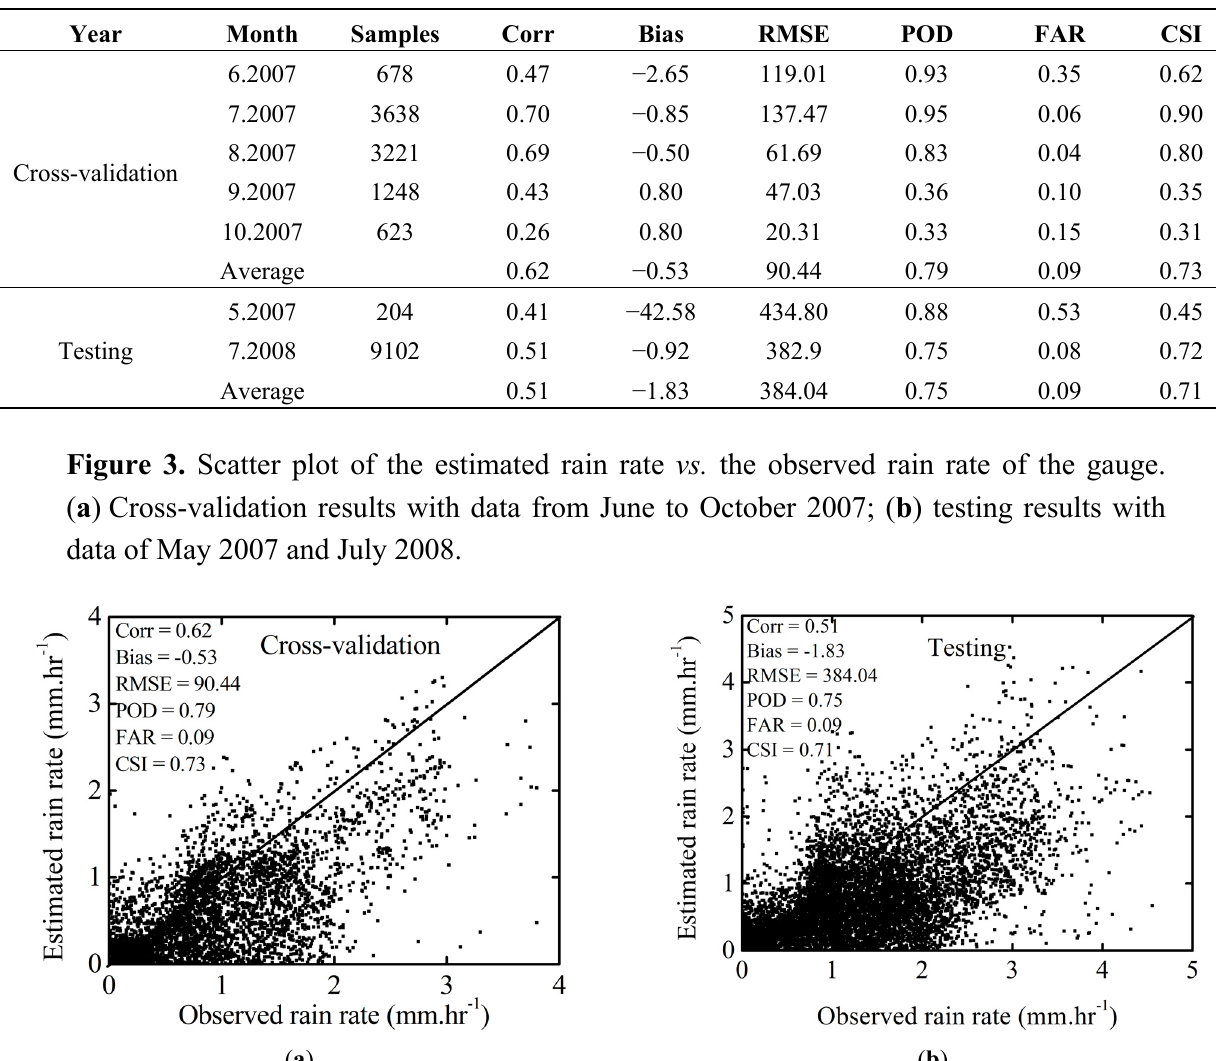
Table 5. The estimation result for the six-hour rain rate in 2007 and 2008. POD, probability of detection; FAR, false alarm ratio; CSI, critical success index.